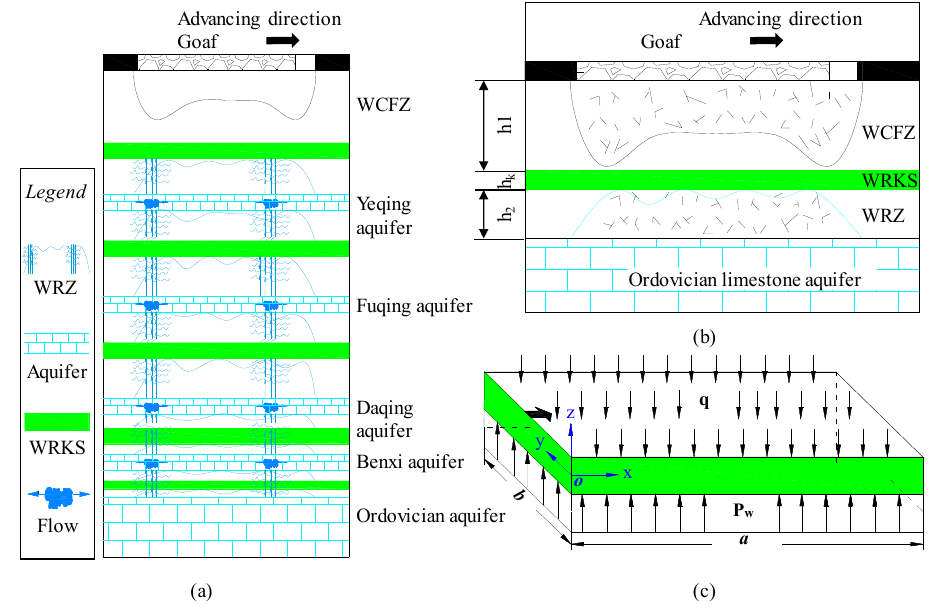
Figure 3. Schematic diagram of water inrush from multiple aquifers floor: ( a ) water inrush mechanism from multiple aquifers floor; ( b ) water in the Ordovician limestone aquifer rising to the Yeqing aquifer; ( c ) mechanical model of the water-resisting key strata in the floor.